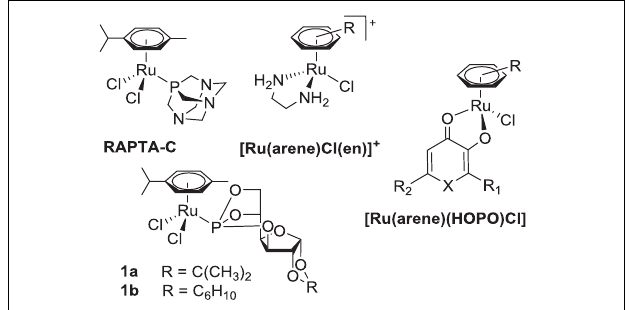
FIGURE 1 | Structures of selected Ru II (arene) anticancer complexes. activity, which is a potential target for anticancer metallodrugs (Fricker,